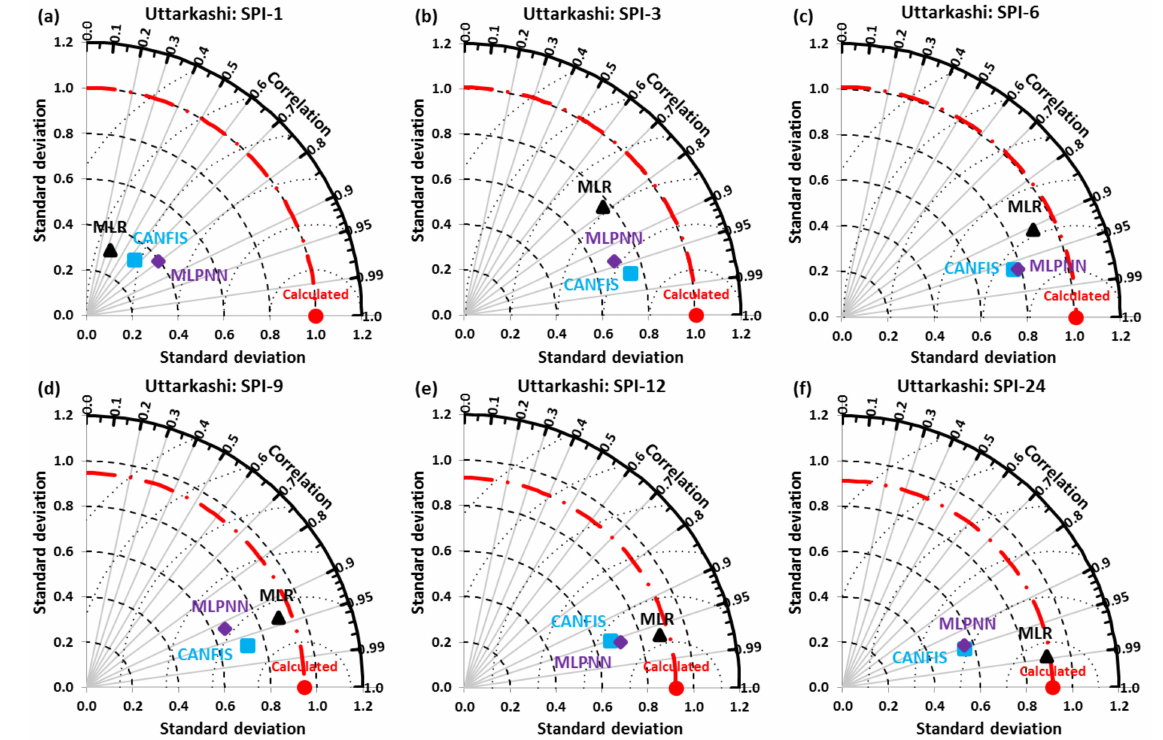
Figure 17. ( a – f ) Taylor diagram of predicted and calculated multi-scalar SPI at Uttarkashi station.